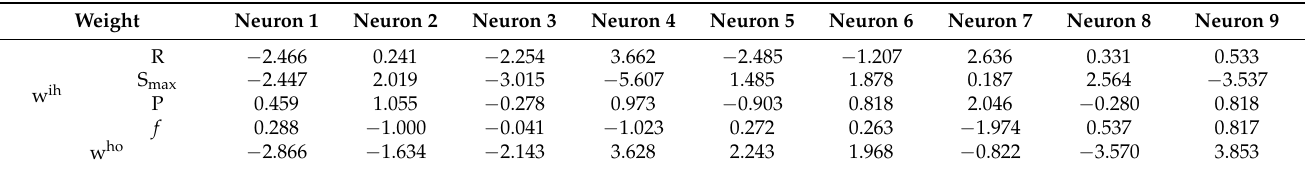
Table 5. Connection weights of the BR-BPNN.